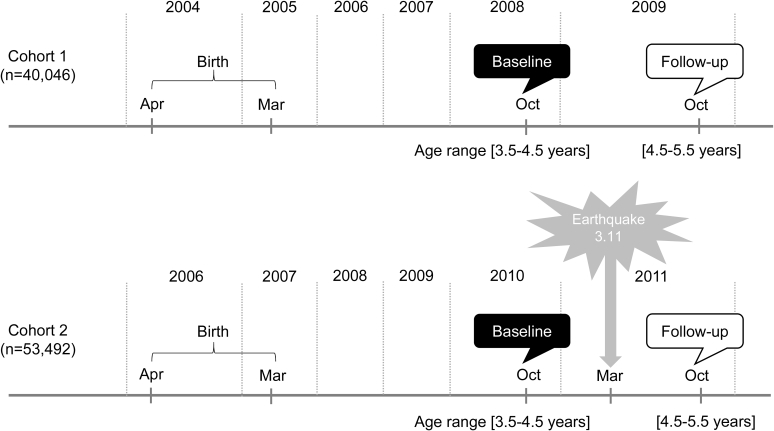
Study timeline. Study subjects in cohort 1 were young children born from April 2, 2004 to April 1, 2005, and were attending nursery school classes for 5-year-olds in 2010; cohort 1 did not experience the earthquake during their nursery schools days. In contrast, study subjects in cohort 2 were born from April 2, 2006 to April 1, 2007, and were attending nursery school classes for 5-year-olds in 2012; cohort 2 experienced the earthquake during their nursery schools days. Thus, cohort 1 was a historical control of the earthquake. The baseline survey for both cohorts was performed when the children were aged 3.5–4.5 years (i.e., in October 2008 for cohort 1 and in October 2010 for cohort 2). The follow-up survey was performed 1 year after baseline (i.e., in October 2009 for cohort 1, and October 2011 for cohort 2).